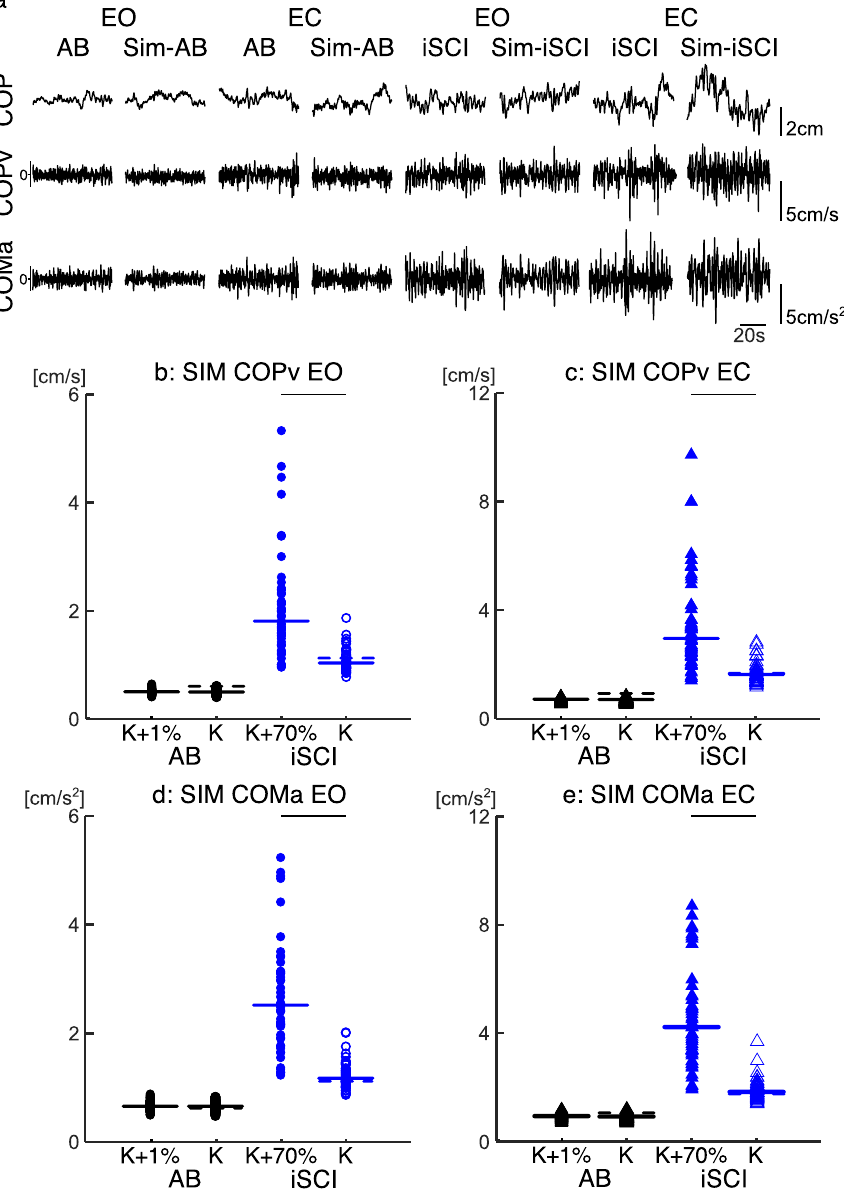
Figure 6. Example of the simulated postural sway (standard deviation of the COPv and COMa), and the comparison of an experimentally matched postural sway to postural sway due to an increased mechanical stiffness. ( a ) Representative 60 s traces for the experimental (AB/iSCI) and simulated (Sim-AB/Sim-iSCI) COP, COPv and COMa in both EO and EC conditions. ( b ) Distribution of the fluctuation of the COPv in the EO condition. ( b ) Distribution of the fluctuation of the COPv in the EC condition. ( c ) Distribution of the fluctuation of the COMa in the EO condition. ( d ) Distribution of the COMa in the EC condition. Simulation data presented for the Sim-AB (black, N = 137) and Sim-iSCI (blue, N = 55) groups in both EO (circles) and EC (triangles) conditions for periods of co-contraction (K + %—filled shapes) and no-co-contraction (K— empty shapes). Thick horizontal lines represent the group median, horizontal dashed lines represent the target experimental postural sway data used to determine the gains sensory and internal noise for the simulations. Individual data are plotted. Thin horizontal lines above the plots represent significant differences (p <